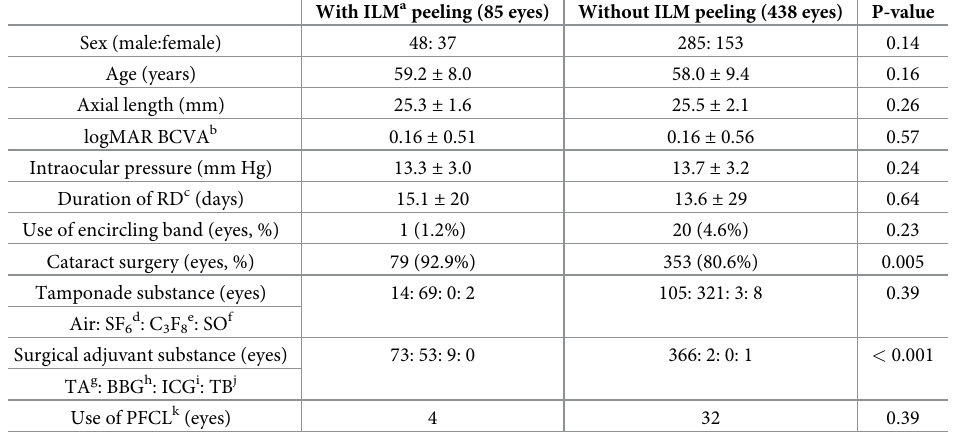
Table 1. Baseline characteristics and surgical details for the eyes with a macula-on rhegmatogenous retinal